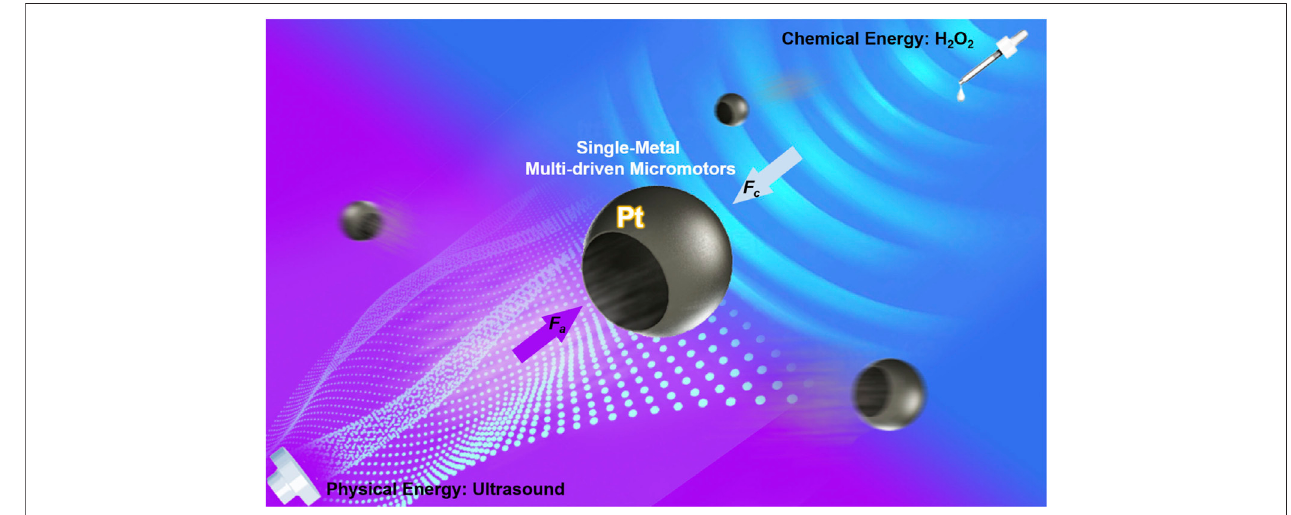
FIGURE 1 | Schematic of hybrid Pt micromotors operating in a complicated environment, either with fuel or without fuel. F c is the force generated by chemical reaction; F a is the force generated by physical